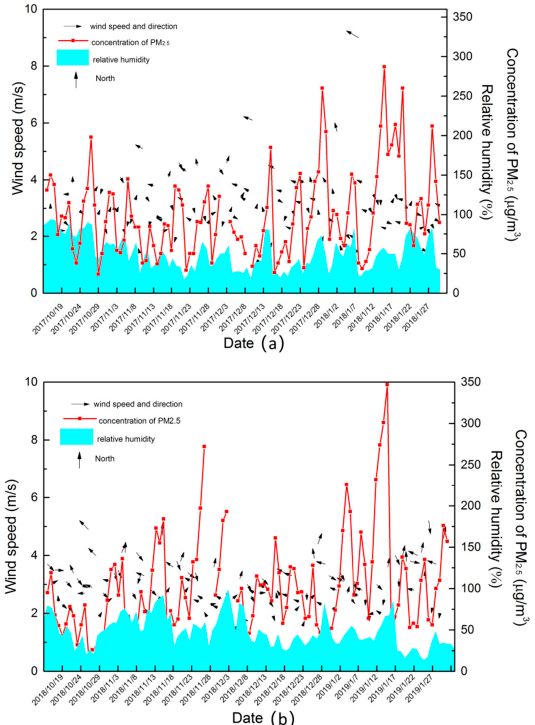
Figure 6. The diagram variations of meteorological parameters and concentration of PM 2.5 at the autumn–winter seasons of 2017–2018 ( a ) and 2018–2019 ( b ). In order to explore the correlations between the concentrations of PM 2.5 , O 3 , and the meteorological parameters, Kendall’s Tau coefficients were calculated, and the calculation results are shown in Table 3. It can be seen in Table 3, both PM 2.5 and O 3 had a weak cor- relation with the average air pressure. It can be seen that wind speed had a positive cor- relation with the concentration of O 3 and had a negative correlation with the concentration of PM 2.5 . Thus, it is suggested that wind had the opposite effects on the formation of PM 2.5 and O 3 . The formation of O 3 mainly depended on the secondary formation of the emission pollutants, and it was speculated that wind could increase the disturbance of the chemical matters in the atmosphere, further increase the reactants contacting probability of O 3. As for PM 2.5 , nucleation is the main step for the formation of PM 2.5 . However, high wind speed increases the disturbance of airflow, inhibiting the forming of the nucleus. It also can be seen in Table 3, the temperature had a higher Kendall’s Tau coefficient with the concentration of O 3 than that of PM 2.5 , suggesting that O 3 is affected more easily by temperature. Higher temperatures were beneficial for the photochemical reaction to form O 3 , and went against the coagulating effects for forming PM 2.5 . The average relative humidity also had a positive correlation with the concentration of PM 2.5 , which demon- strated that water played an important role in the formation of PM 2.5 , because water mol- ecules are an important component in the nucleation process.